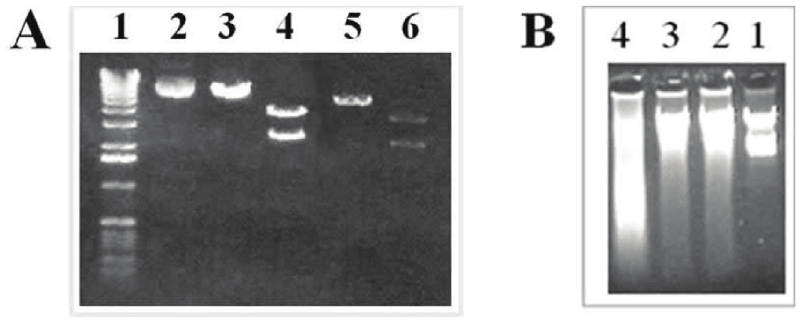
Figure 8. Agarose gel electrophoresis of DNA samples. (A) Plasmid DNA: M W marker (lane 1), control DNA (lane 2), control DNA cut with Eco RI, which linearized the plasmid but would not alter the size (lane 3), control DNA cut with Pst I showing 2 fragments with different lengths (lane 4), DNA treated with DMF and cut with Eco RI (lane 5) or Pst I (lane 6); (B) Calf thymus DNA: M W marker (lane 1), control DNA (lane 2), DNA treated with water (lane 3), DNA treated with DMF (lane 4).